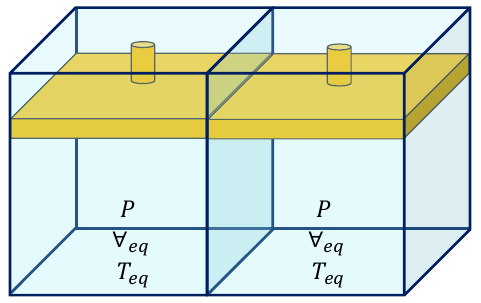
Figure 3. Equilibrium state of the coupled thermodynamic